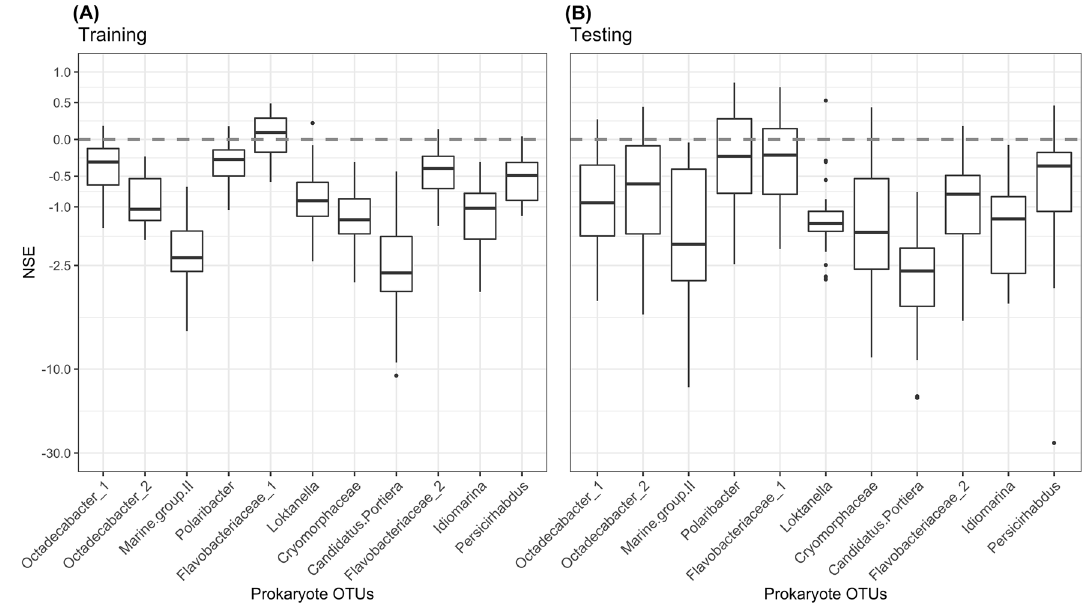
Figure 3. Nash–Sutcliffe Efficiencies (NSE) of the iterative random forest models when tested against ( a ) training and ( b ) testing data subsets of microbial OTUs that are part of the marine microbiome dataset collected from Santa Cruz Wharf. X-axes are the microbial strains and the y-axes are the NSE